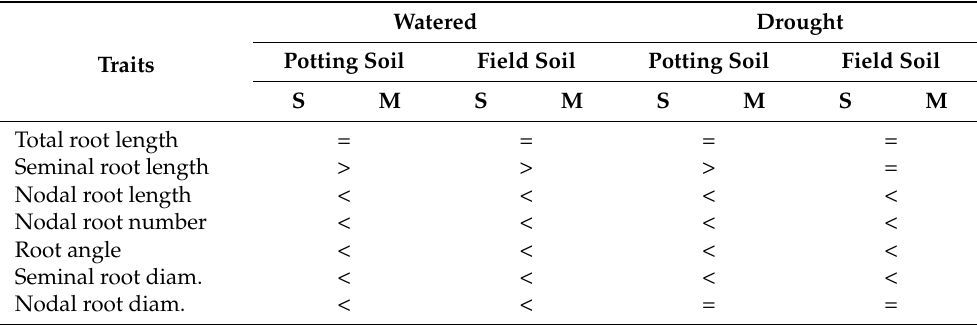
Table 1. Relative properties of root traits for Spica (S) and Maringa (M) grown in two soil types under watered and drought conditions. Watered Drought Potting Soil Field Soil Potting Soil Field Traits